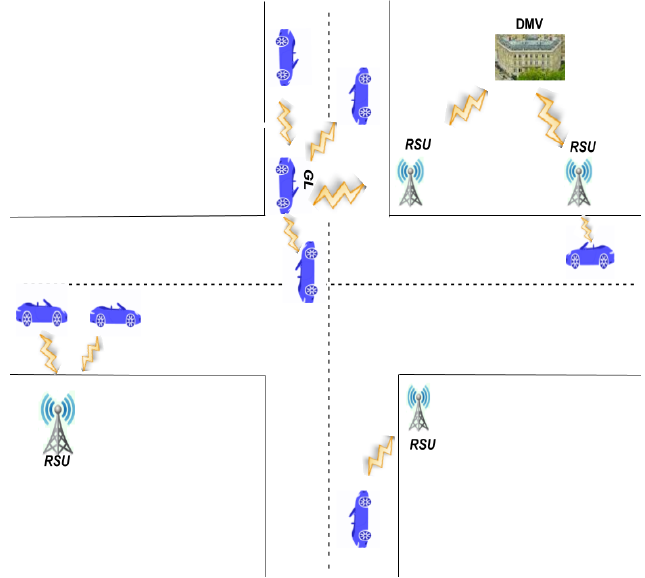
Figure 1. System model for